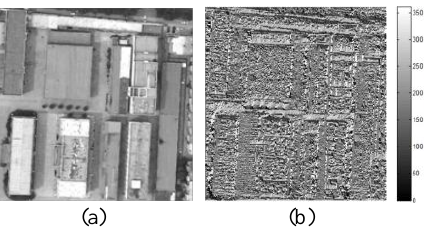
Figure 5. The orientation of phase congruency. (a) the image. (b) its orientation of phase congruency.